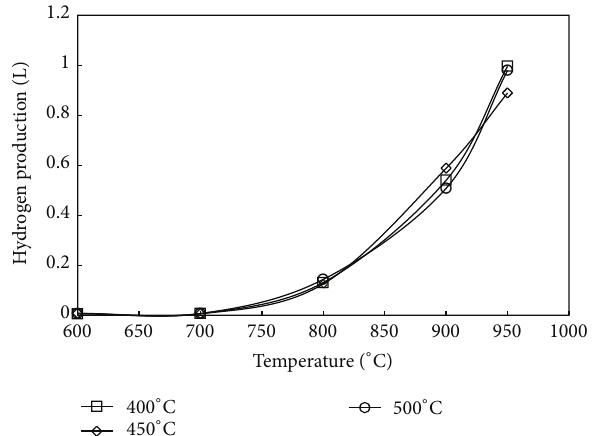
Figure 6: The catalytic activity of different silver calcination tem- peratures.